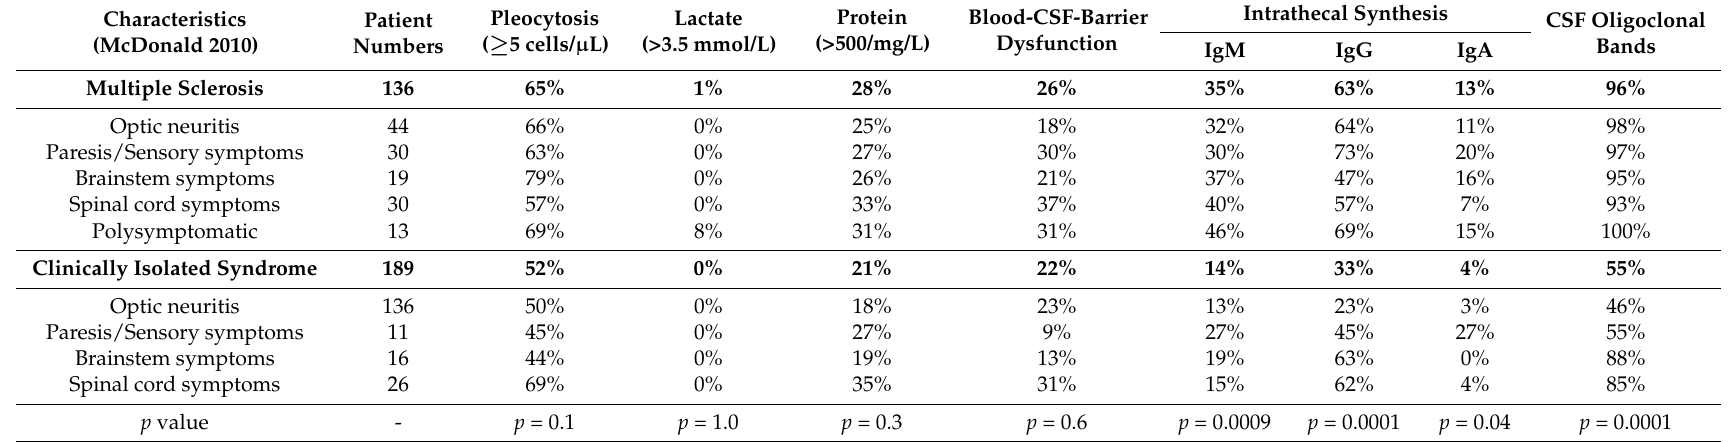
Table 1. Cerebrospinal fluid